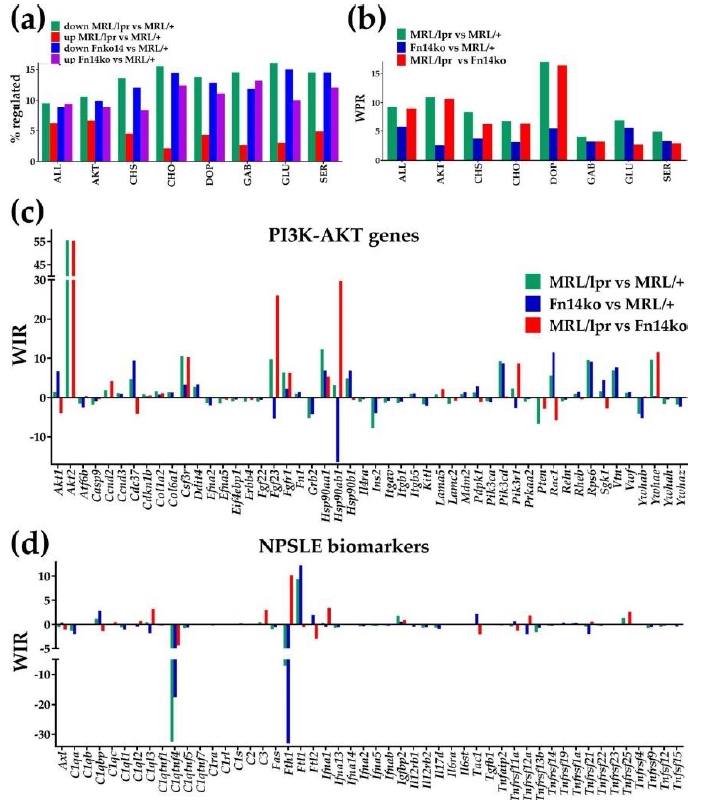
Figure 3. Transcriptomic regulation of selected signaling pathways, PI3K-AKT individual genes, and neuropsychiatric systemic lupus erythematosus (NPSLE) biomarkers. ( a ) Percentages of up- and down-regulated genes. ALL = all genes, AKT = PI3K-AKT signaling pathway, CHS = chemokine signaling pathway, CHO = cholinergic transmission, DOP = dopaminergic transmission, GAB = GABAergic transmission, GLU = glutamatergic transmission, SER = serotonergic transmission. ( b ) Weighted Pathway Regulation (WPR) of individual pathways and the WPR ratio of the two profiled mice models. ( c ) Weighted Individual (gene) Regulation (WIR) of selected genes involved in the PI3K-AKT signaling pathway but not in neurotransmission (excepting Akt2 ). ( d ) WIR scores of NPSLE biomarkers in all three comparisons among the phenotypes.